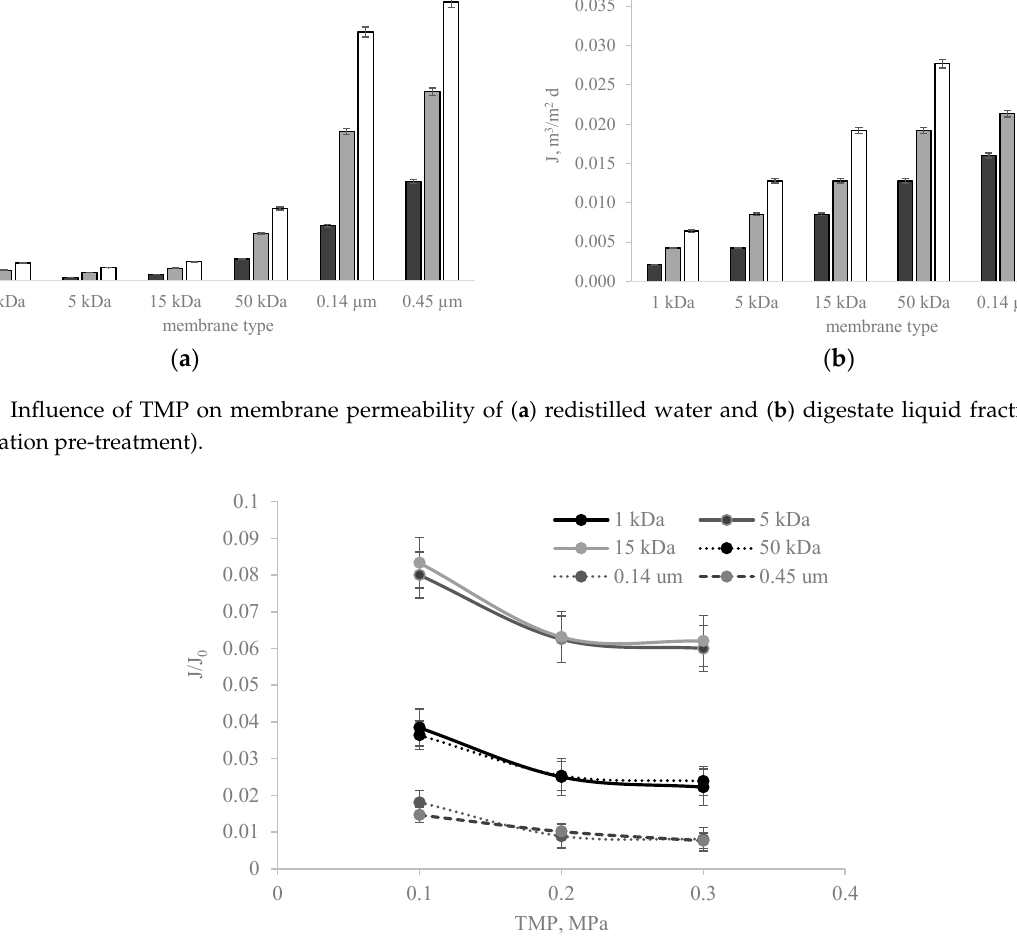
Figure 7. Influence of TMP on membrane relative permeability of digestate liquid fraction.